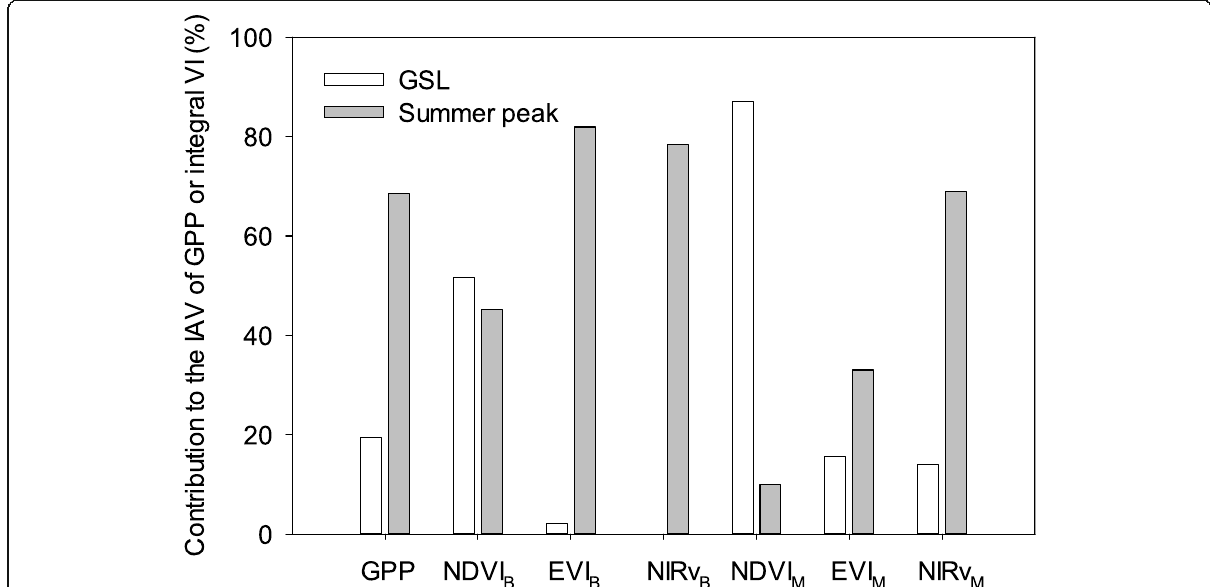
Fig. 4 Relative importance of the growing season length (GSL) and summer peak to the interannual variation in gross primary production (GPP) or integral vegetation index (VI). NDVI B : broadband normalized difference vegetation index, EVI B : broadband enhanced vegetation index, NIRv B : broadband near-infrared albedo of vegetation, NDVI M : MODIS normalized difference vegetation index, EVI M : MODIS enhanced vegetation index, NIRv M : MODIS near-infrared reflectance of